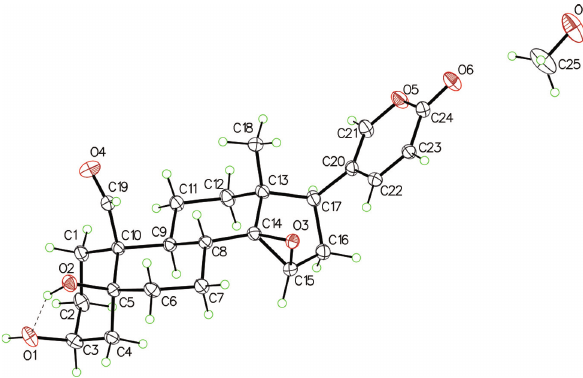
Table 2: Fractional atomic coordinates and isotropic or